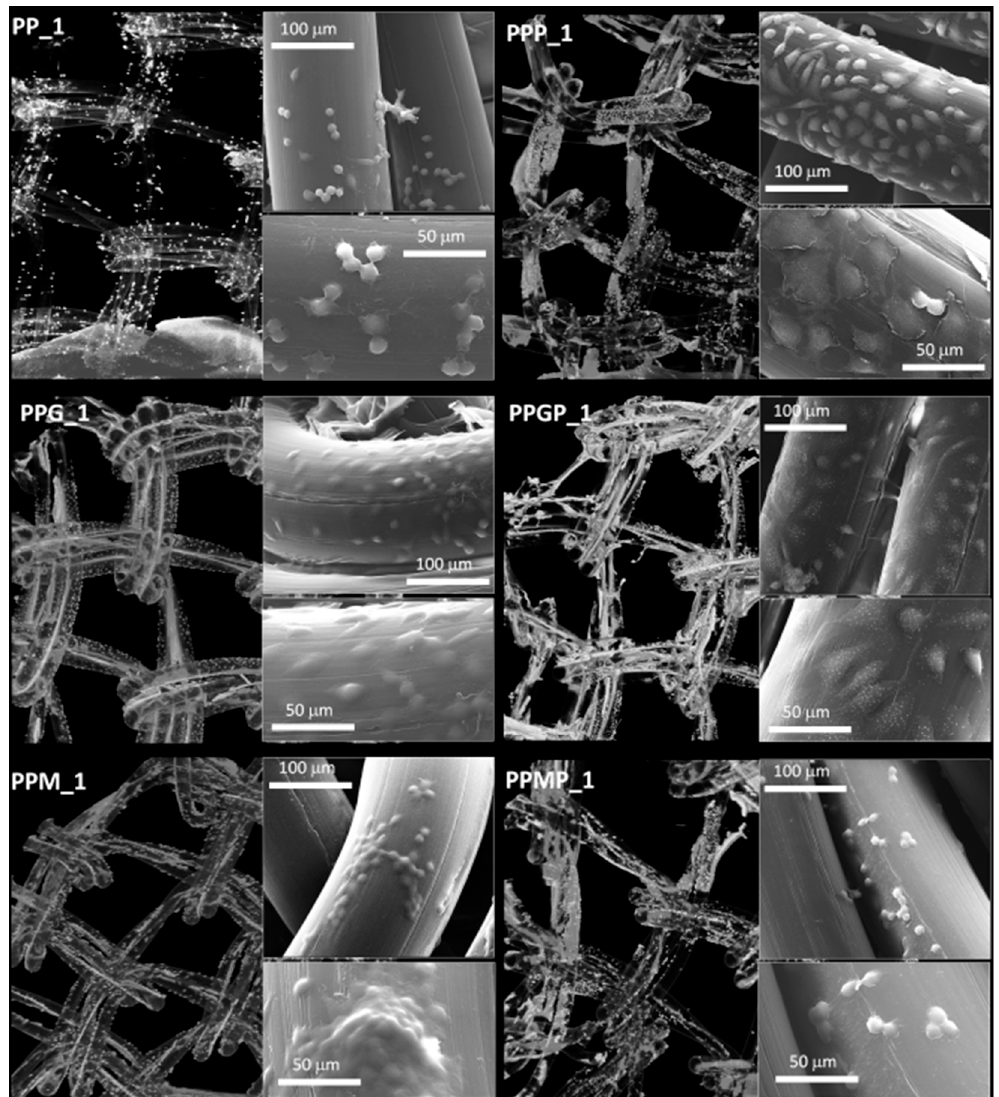
Figure 4. Micro-CT images and SEM micrographs (insets) at one day post-seeding; left column, top to bottom: PP_1 and protein-coated PP (PPG_1 and PPM_1); right column, top to bottom—PRP-treated PP (PPP_1) and PRP-treated hydrogel-coated sample PPGP_1 and PPMP_1.